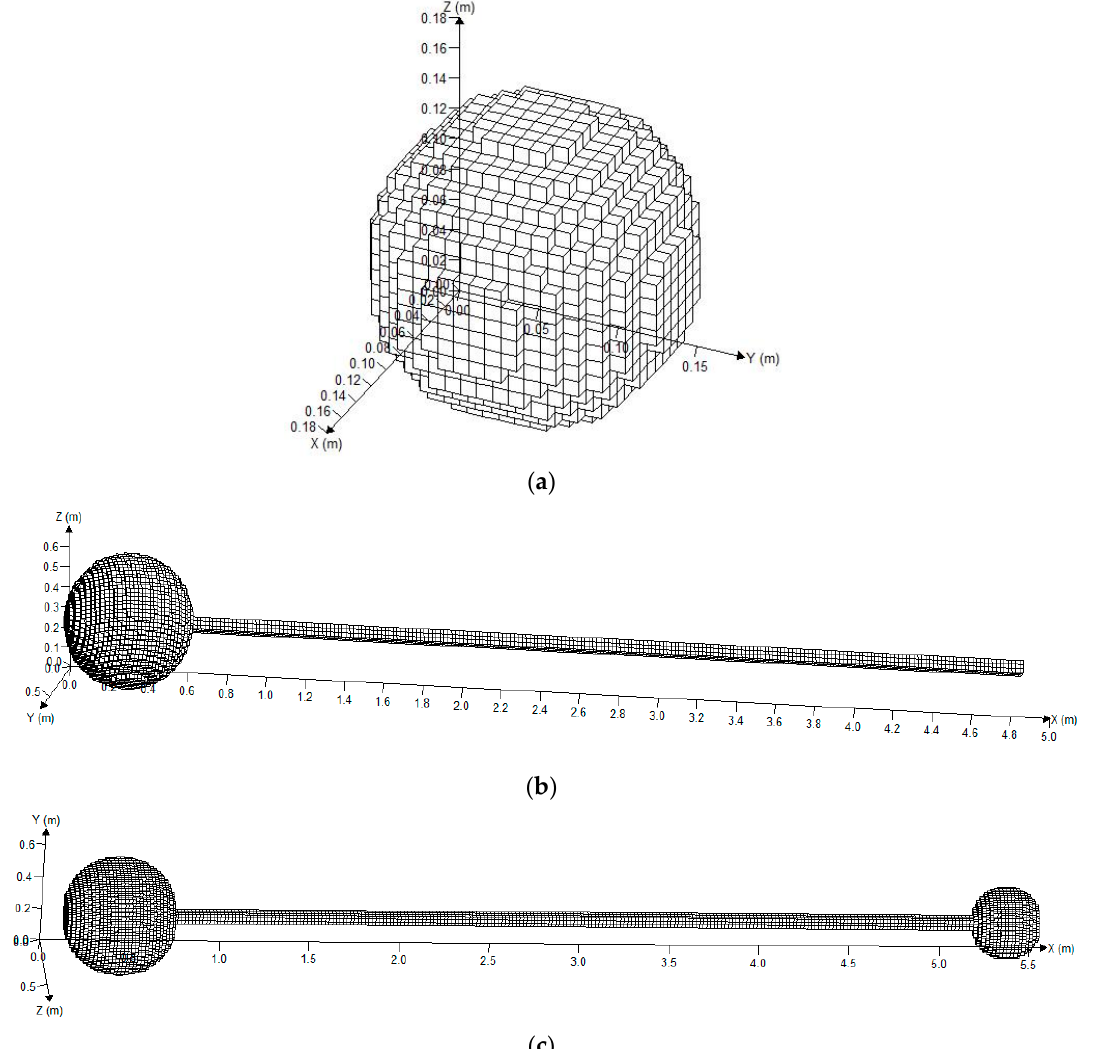
Figure 2. Grid division on the model of the three structures. ( a ) Grid division on the model of the spherical vessel; ( b ) grid division on the model of the single sphere with a pipe; ( c ) grid division on the model of the big vessel connected with the small vessel.